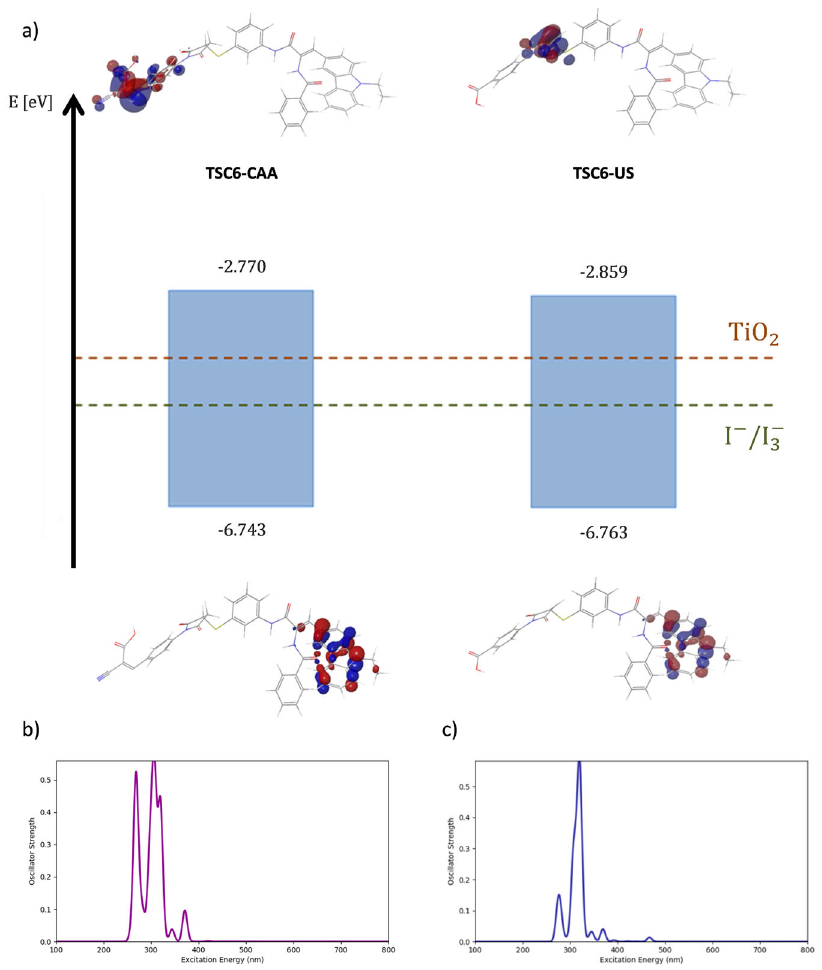
Fig. 6 Results of DFT and TD-DFT calculations for TSC6-CAA and TSC6-US. a HOMO/LUMO energy diagrams and structures. b Absorption spectrum for TSC6-CAA . c Absorption spectrum for TSC6-US